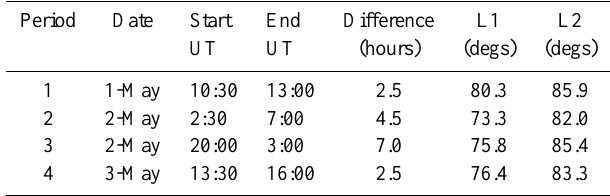
Table 1. Details of the Polar cusp/cleft